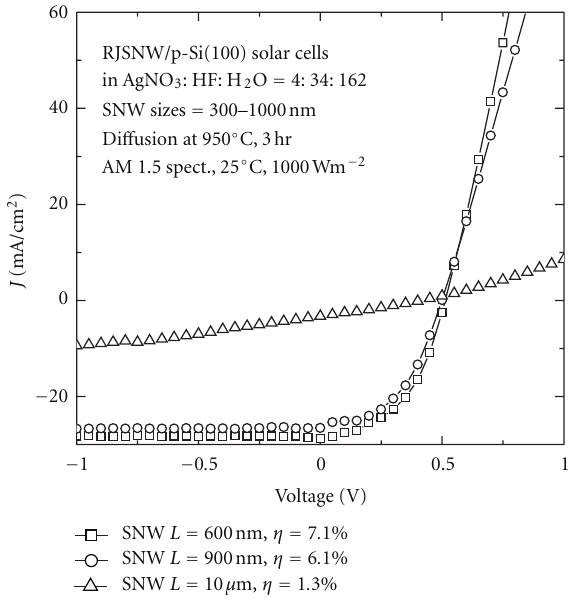
Figure 9: J-V curves of various illuminated (AM 1.5) n-type SNW/p-Si(100) solar cells with SNW array lengths of 600, 900, and 10000 nm. Etching conditions were aqueous AgNO 3 /HF/H 2 O mixture chemical solution in a ratio of 4:34 :162 (volume) at 25 ◦ C for (a) 1.5, (b) 3, and (c) 30min. All SNW/p-Si(100) structures were formed by di ff usion of phosphorus at 950 ◦ C for